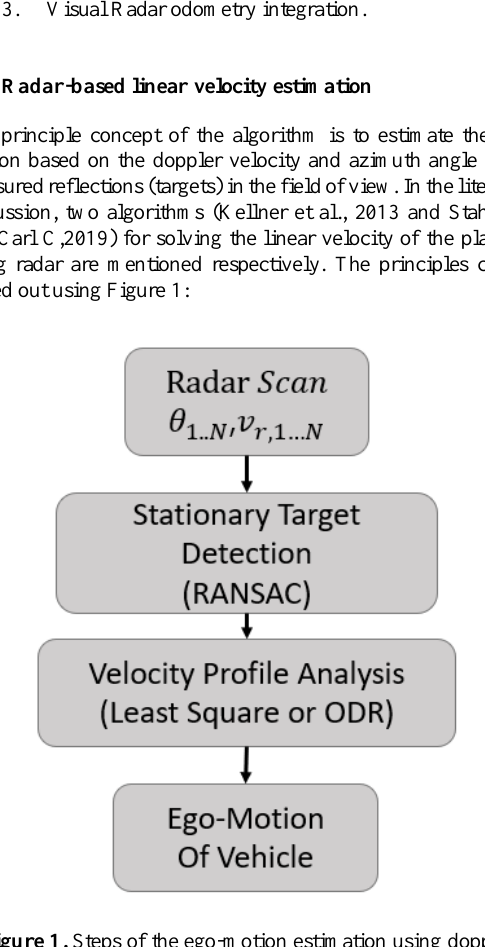
Figure 1. Steps of the ego-motion estimation using doppler